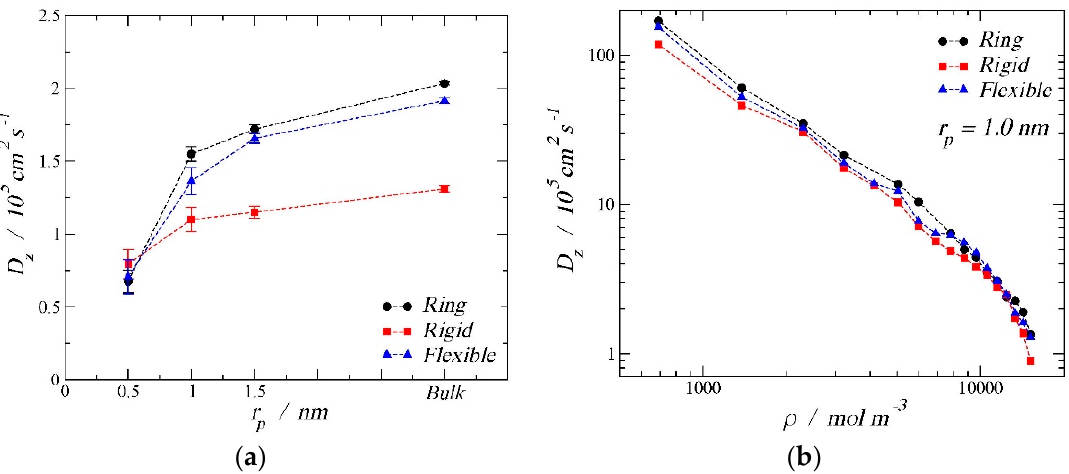
Figure 7. Self-diffusion coefficient in the z direction, D z, for the three morphologies at 150 K in a cylindrical nanopore. ( a ) The image on the left shows the diffusion coefficient as a function of the pore radius: 0.5 nm, 1.0 nm, 1.5 nm, and bulk phase at the high-density limit (15,167 mol/m 3 ). ( b )The image on the right shows diffusion coefficient as a function of the pore density for r p = 1.0 nm.